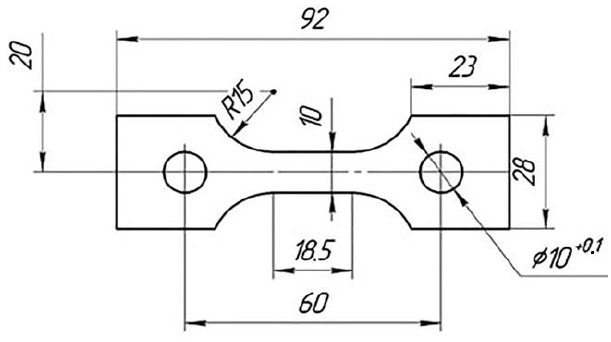
Figure 1. Test specimen (dimensions indicated in mm).